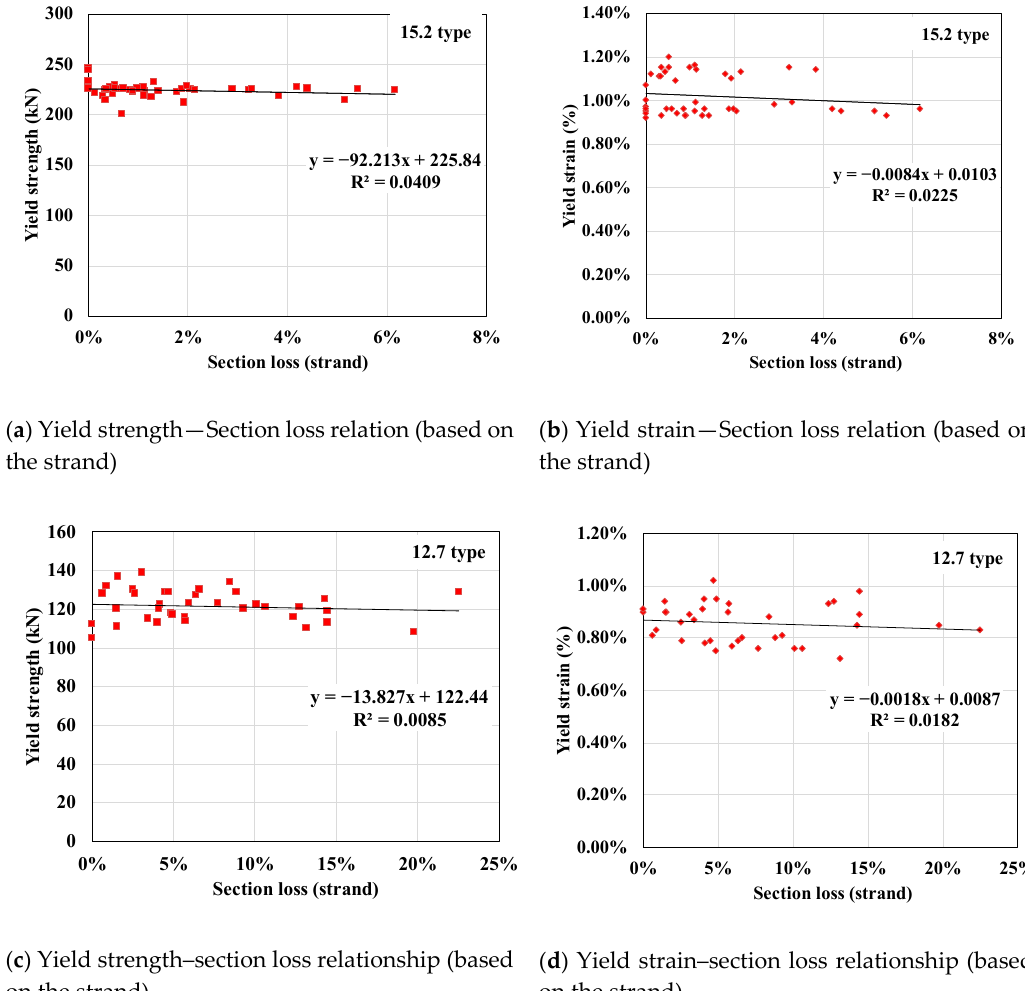
Figure 12. Yield properties of corroded strands, evaluated via section loss of strands.